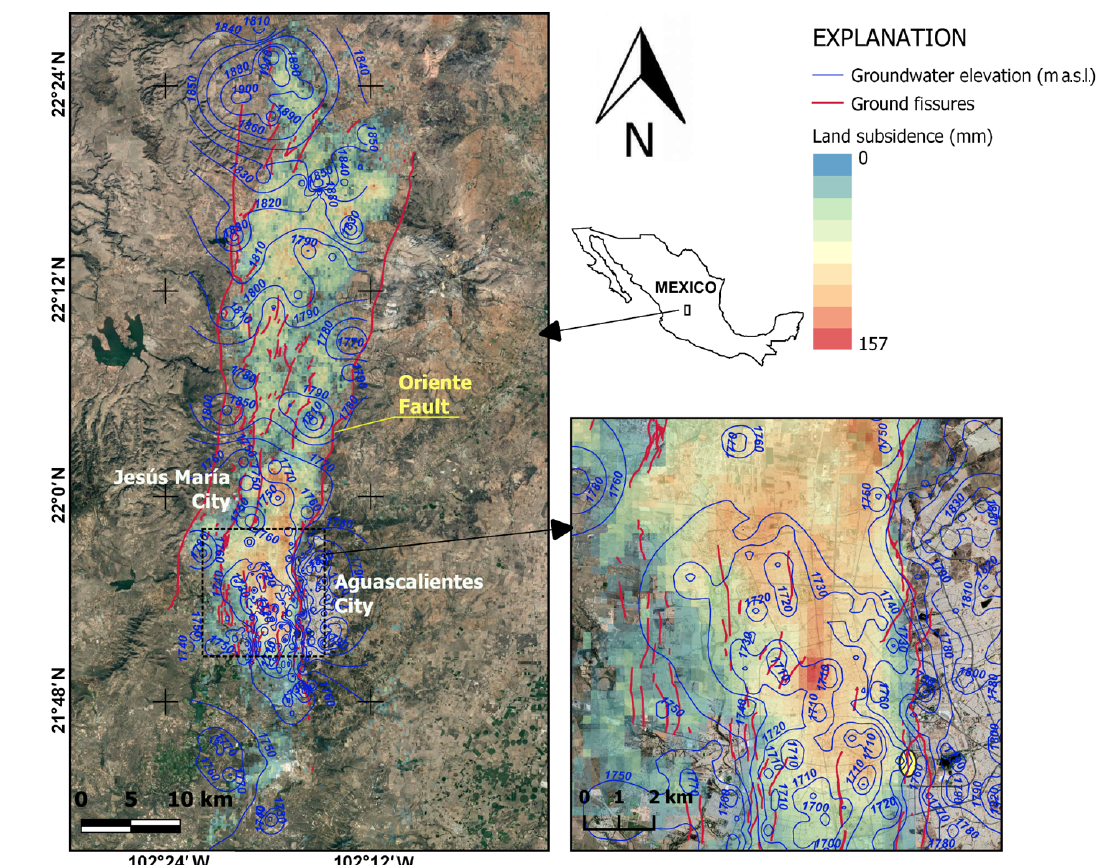
Figure 1. Land subsidence, earth fissuring and water level elevation in the valley of Aguascalientes after 2017. Figure based in a ©Google Earth complement inside